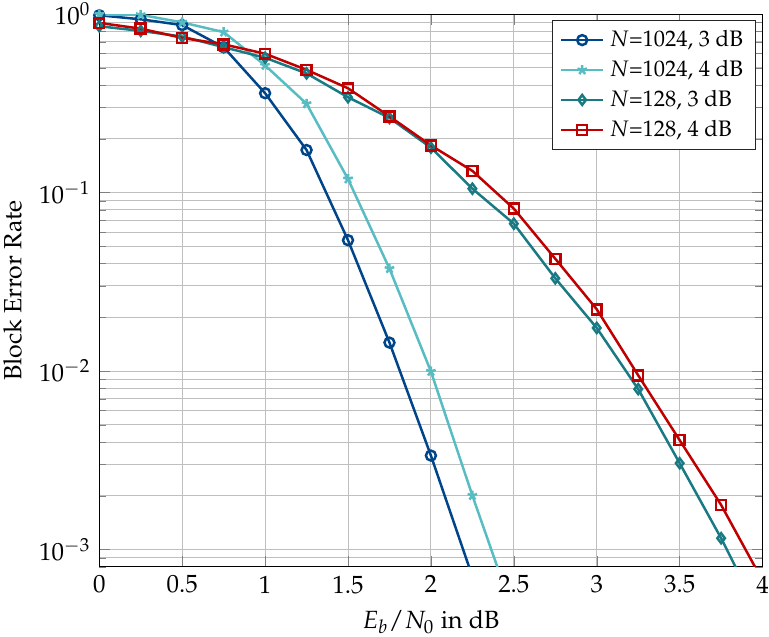
Figure 20. Effect of design E b / N 0 in the mismatched use of the information bottleneck decoders. N = 128 or 1024, |T | = 16, N = 128, N L = 32, N crc = 16, and code rate